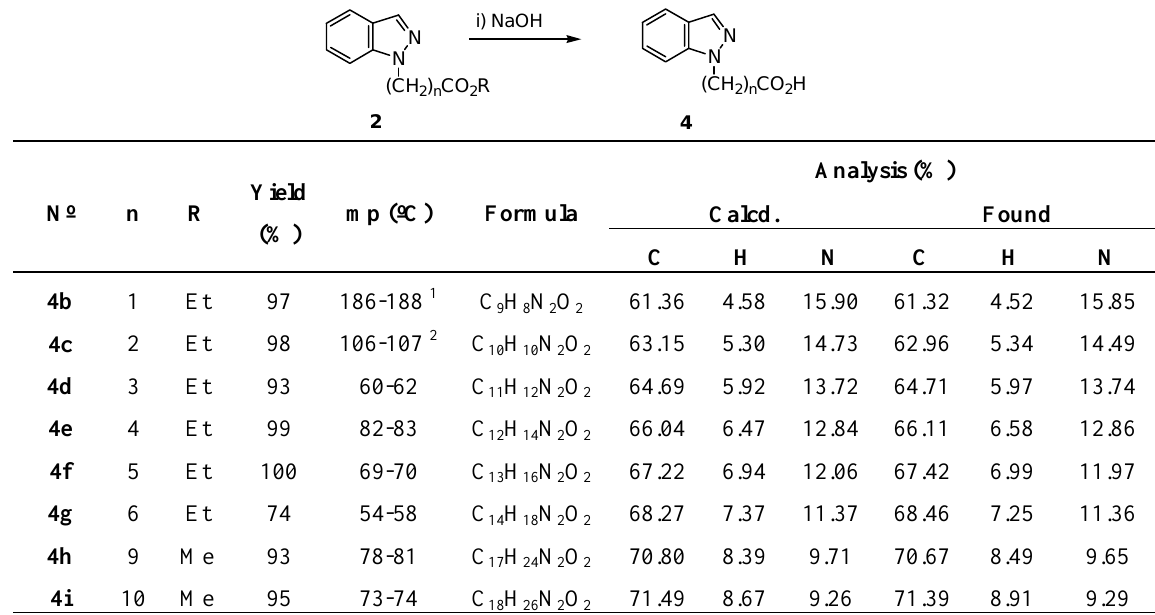
Table 2. Physical-chemical characteristics and elemental analysis of indazole carboxylic acids